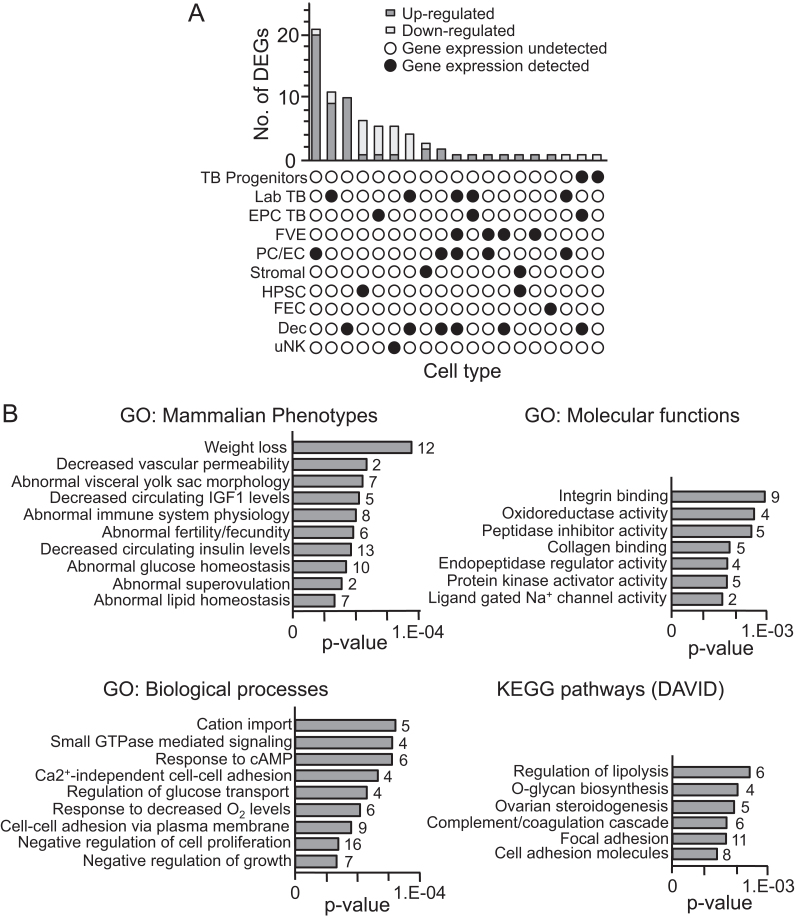
Spatial expression and ontological analyses of DEGs identified in placentas of transferred mouse conceptuses at E10.5. (A) UpsetR plot summarizing the predicted spatial expression of 79 DEGs in the mouse placentation site. Data were largely obtained from a published single-cell RNA sequencing data set on whole mouse placenta at E14.5 (Han et al. 2018). See also Supplementary Table 3. Dark grey bars, upregulated DEGs; light grey bars, downregulated DEGs; black circles indicate cell-specific expression; white circle indicates that expression was undetected. TB, trophoblast; Lab TB, labyrinth trophoblast; EPC TB, ectoplacental cone trophoblast; FVE, fetal endothelial vascular cells; PE/EC, parietal endoderm or endodermal cells; HPSC, haematopoietic stem cells; FEC, foetal erythroid cell; Dec, decidua; uNK, uterine natural killer cell. (B) Gene ontology term enrichment analysis for DEGs in placentas of transferred conceptuses. The numbers of genes in each term are also given.